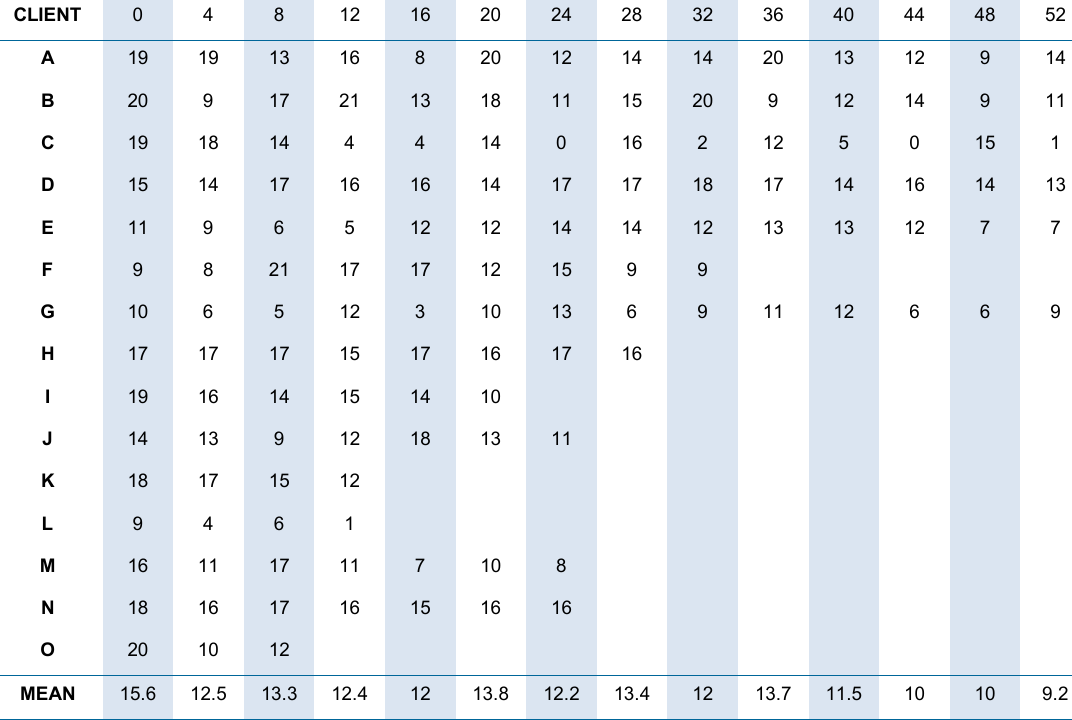
Table 12: Mean GAD-7 score: all clients